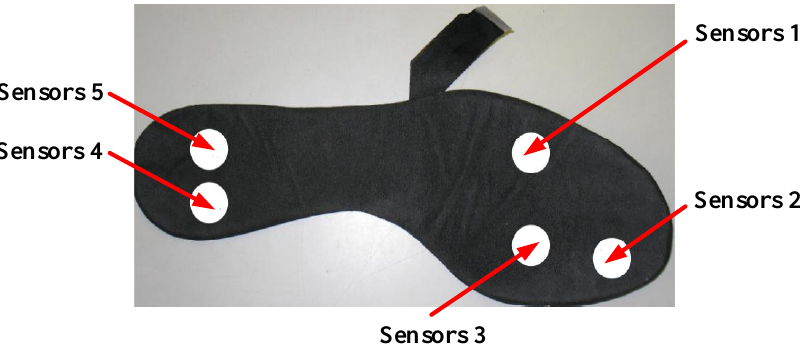
Figure 30. The three sensors placement of Holleczek et al. sensor sock designed. ( a ) three sensors placement; and ( b ) wearable system . Modified from